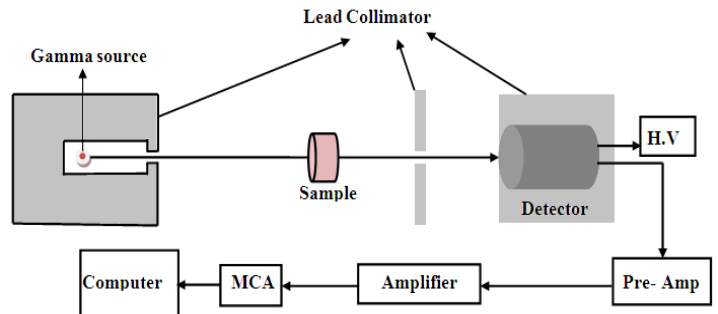
Figure 2. The experimental setup for the determination of the mass attenuation